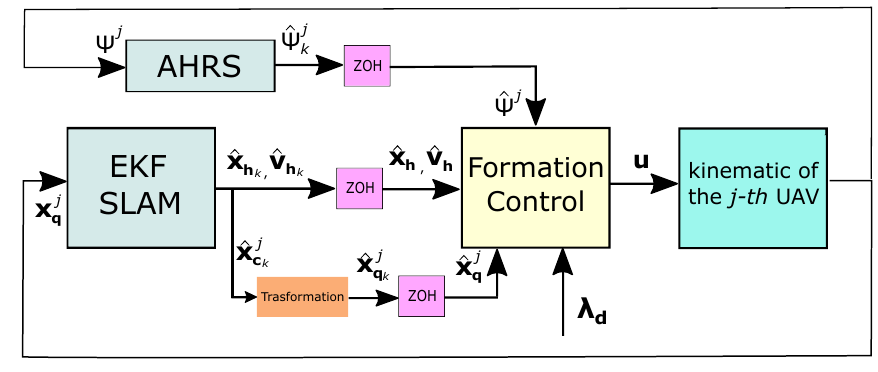
Figure 7. Control